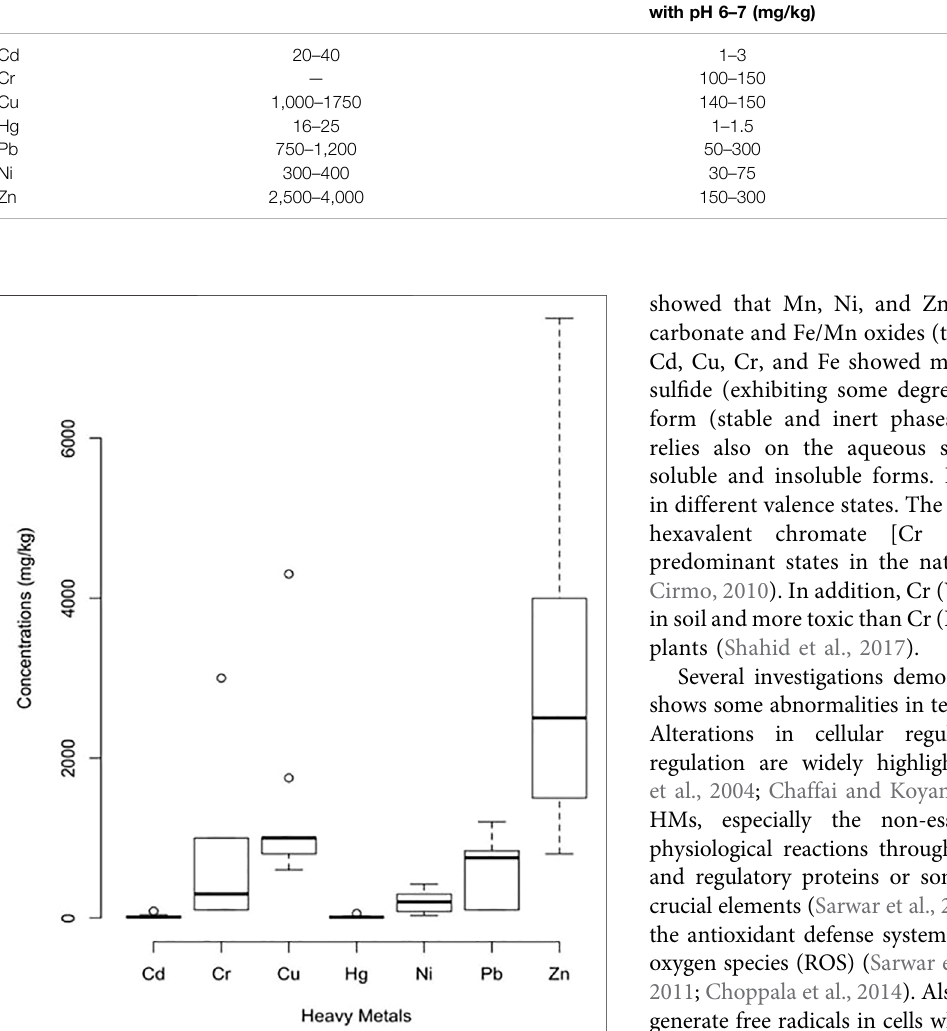
Frontiers in Environmental Science |